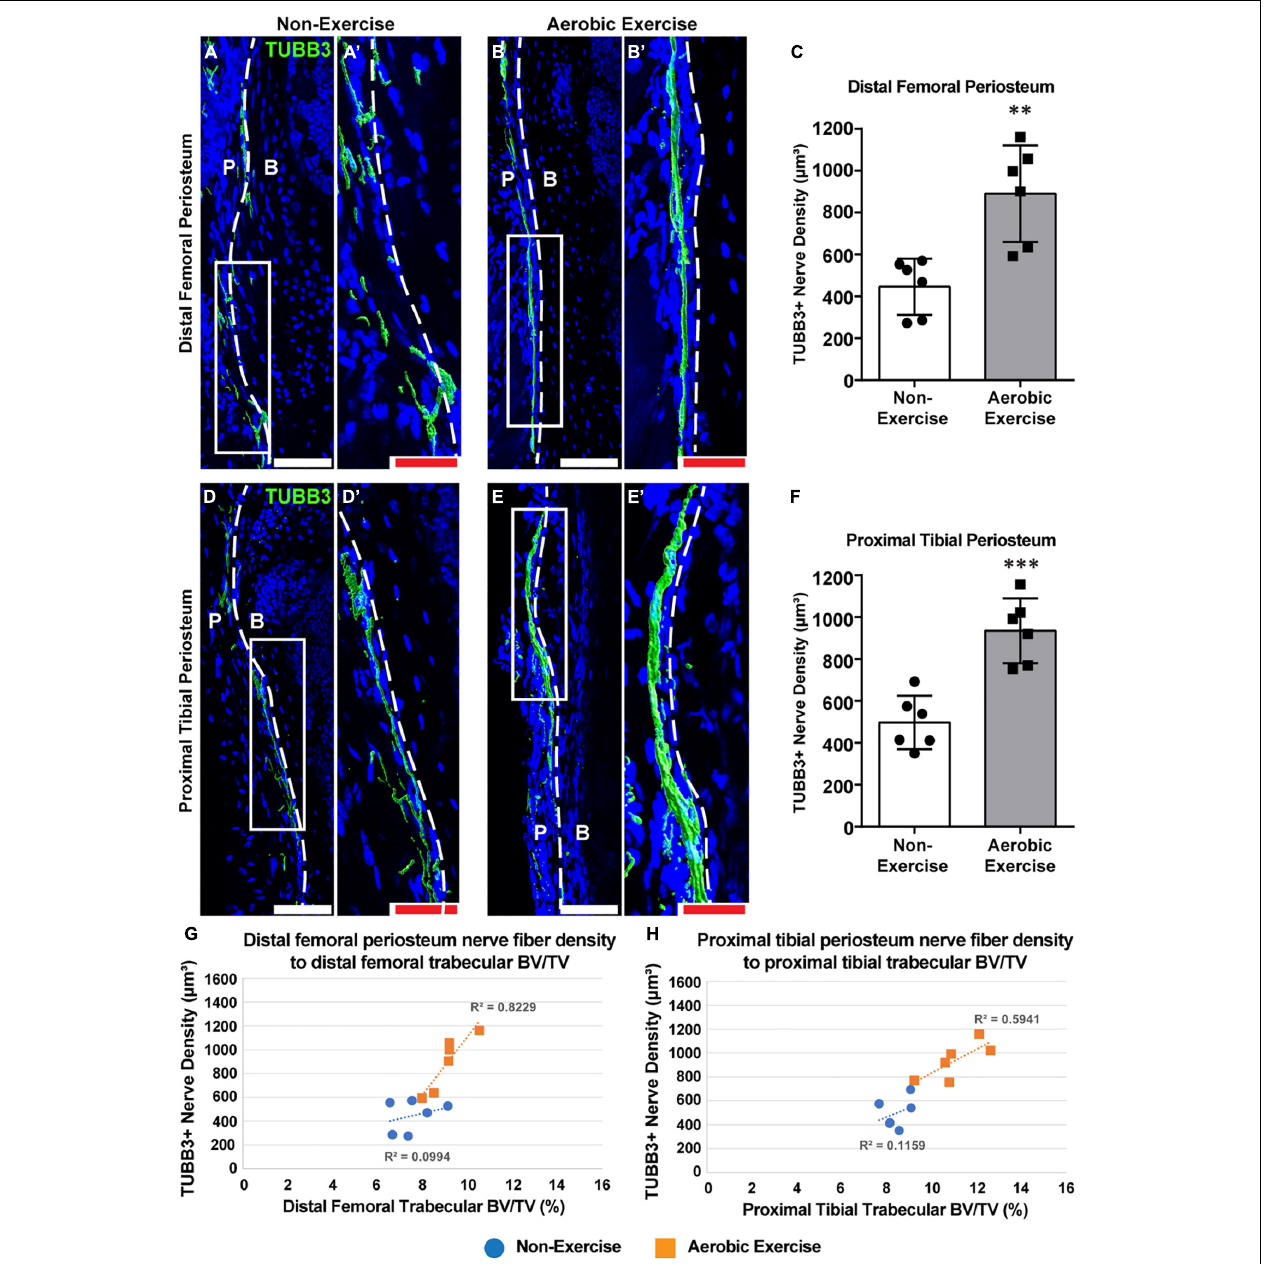
FIGURE 3 | Aerobic exercise training shows greater distal femoral and proximal tibial periosteal innervation with strong association with trabecular bone volume. Representative images of pan-neuronal beta III tubulin (TUBB3) immunohistochemical staining in distal femoral periosteum of Non-Exercise (A) and Aerobic Exercise (B) . Higher magnification images were shown (A (cid:48) ,B (cid:48) ) . Quantification of TUBB3 immunohistochemical staining in the distal femoral periosteum showed higher ( p < 0.01) TUBB3 + nerve fiber density in Aerobic Exercise group (C) . Representative images of pan-neuronal beta III tubulin (TUBB3) immunohistochemical staining in proximal tibial periosteum of Non-Exercise (D) and Aerobic Exercise (E) . Higher magnification images were shown (D (cid:48) ,E (cid:48) ) . Quantification of TUBB3 immunohistochemical staining in the proximal tibial periosteum revealed greater ( p < 0.001) TUBB3 + nerve fibers following aerobic exercise (F) . TUBB3 immunohistochemical staining appears green using the surface rendering function of Imaris analyzing software. Scattergrams showing the association between TUBB3 + periosteal nerve fiber density and trabecular BV/TV in the distal femora (G) and in the proximal tibiae (H) with Non-Exercise group (blue) or Aerobic Exercise group (orange). Statistically significant and strong correlation exists ( R 2 = 0.82, p = 0.012) between periosteal nerve fiber density and trabecular BV/TV in femora [ (G) orange], while not statistically significant but strong relationship ( R 2 = 0.59, p = 0.072) was observed between nerve fiber density and trabecular BV/TV in tibiae [ (H) orange] with aerobic exercise training. No correlations exist between skeletal nerve fibers and femoral and tibial trabecular BV/TV in Non-Exercise groups [ (G,H) blue]. Dashed white line represents a boundary between the periosteum (P) and adjacent cortical bone (B). White scale bar: 100 µ m, red scale bar: 50 µ m. N = 6 per group. Values are means ± S.D. ∗∗ p < 0.01, and ∗∗∗ p <